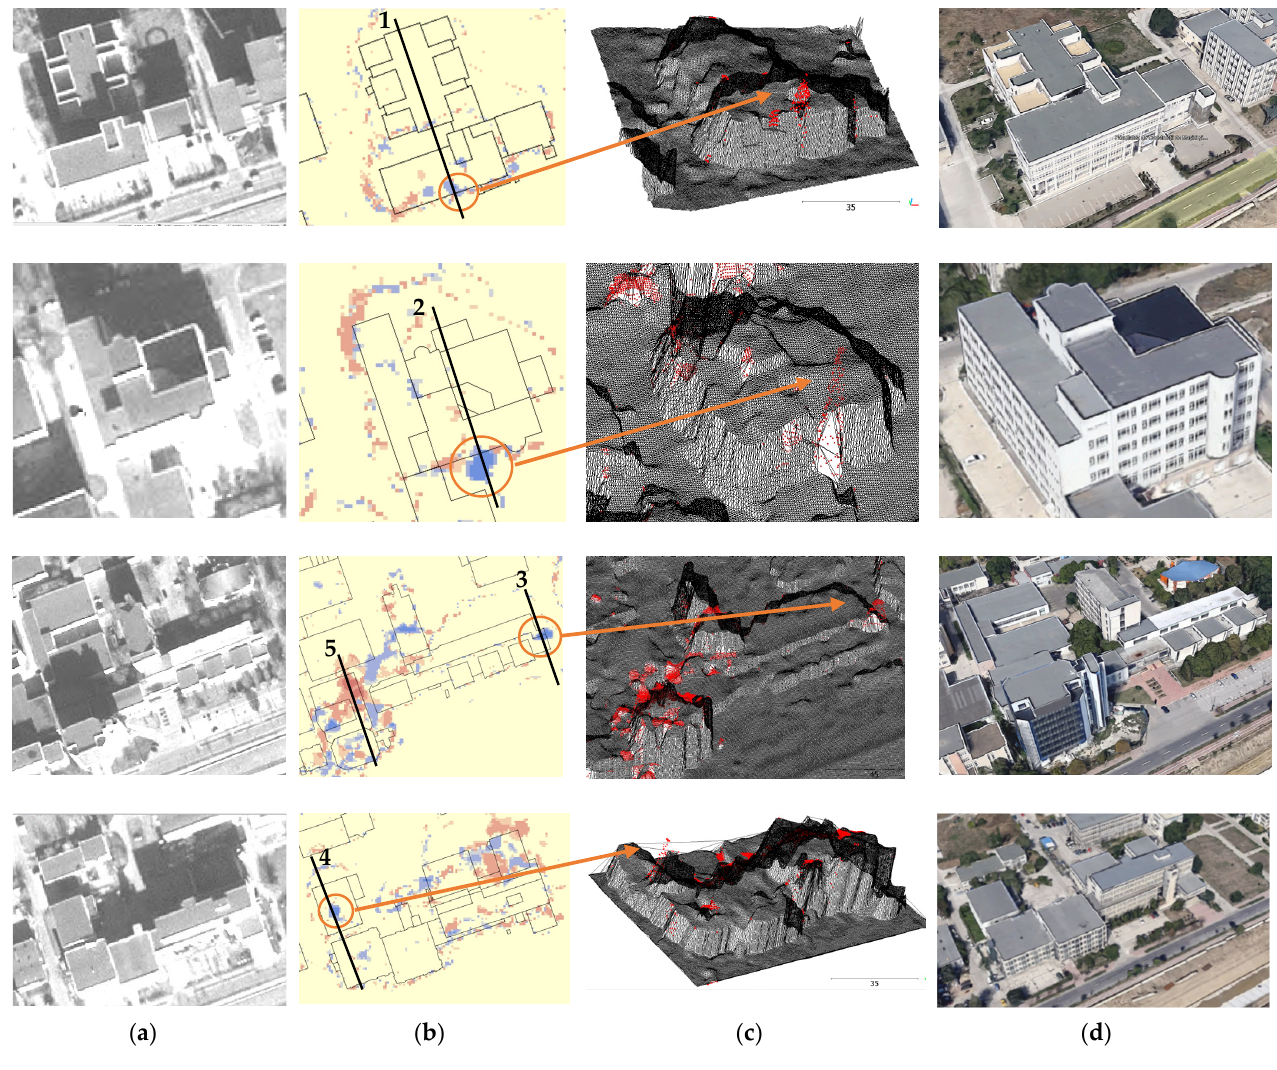
Figure 21. ( a ) Pléiades image detail; ( b ) map of differences between the uncorrected and corrected Pléiades-DSM point clouds and the labeled profile trajectory (black line) (the color legend from Figure 20 is applicable); ( c ) mesh for the corrected Pléiades-DSM and red color uncorrected Pléiades- DSM (orange circles and arrows indicate the positive differences in 3D); ( d ) Google Earth detail.